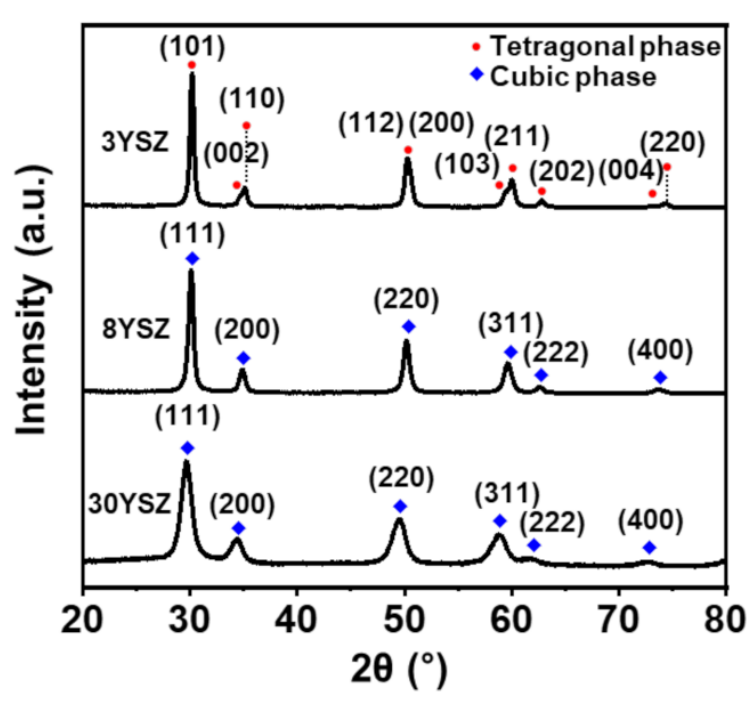
Figure 3. XRD patterns of the YSZ nanospheres. The 3YSZ nanospheres consist of a tetragonal phase ( top ), while the 8YSZ and 30YSZ nanospheres consist of a cubic phase ( middle and bottom , respectively).